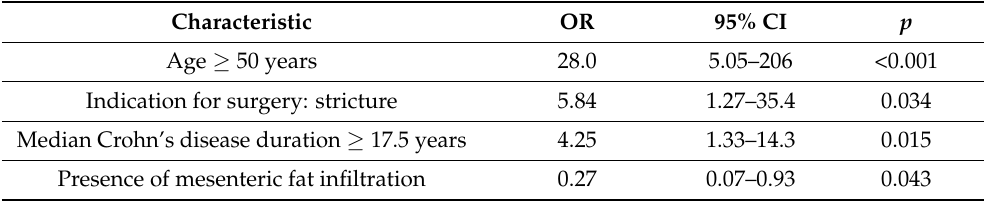
Table 5. Predictors of small bowel neoplasia in multivariable and Cox regression analyses, n = 200. Characteristic